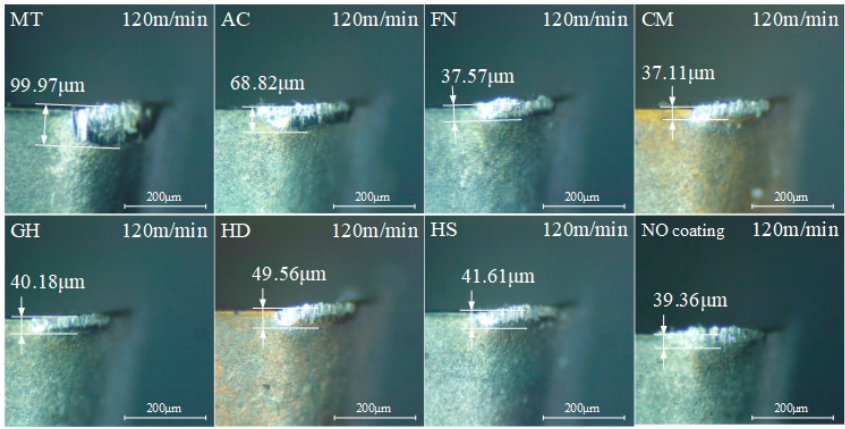
Figure 15. Tool flank wear of different coatings after cutting 1700 m at low speed.